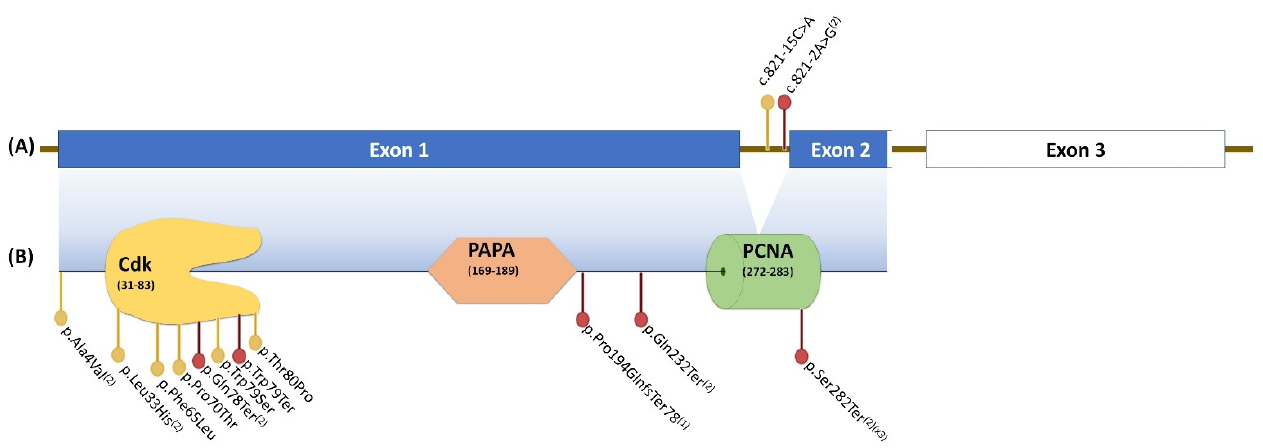
Figure 1. Variants identified along the CDKN1C gene, organised in three exons ( A ). Exons 1 and 2 encode the functional protein ( B ), which is organised into three domains: the cyclin-dependent kinase-inhibitor domain (CdK), the proline–alanine repeats domain (PAPA), and the proliferating cell nuclear antigen domain (PCNA). (1) Variants reported by Kantaputra et al. (2013) [24]; (2) Variants reported by Romanelli et al. (2010) [23]; (2)(X3) Variants reported by Romanelli et al. (2010) that were observed in three different cases. Red dots, loss-of-function variants; yellow dots, missense variants. Clinical data were reviewed for all 21 cases, all of them with cardinal and/or very suggestive features of BWS (Table 2). Macroglossia was observed in all cases. Abdominal